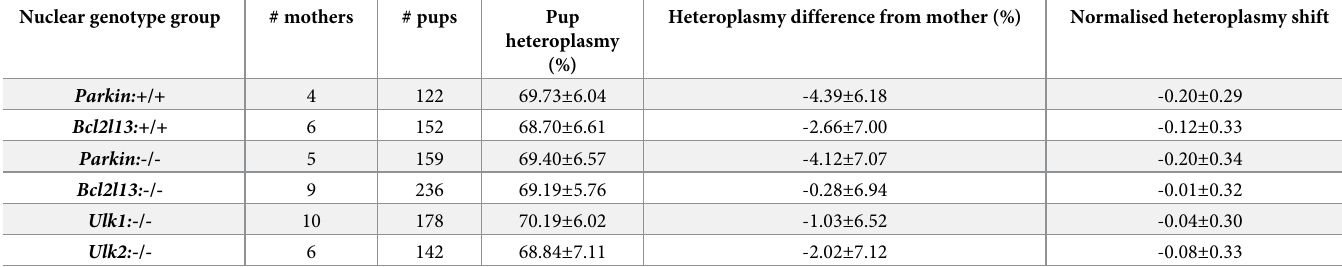
Table 1. Mothers and pups in each genotype group. Pup heteroplasmy, and mother-to-pup heteroplasmy difference and normalised heteroplasmy shift are given as mean ± st.dev. Nuclear genotype